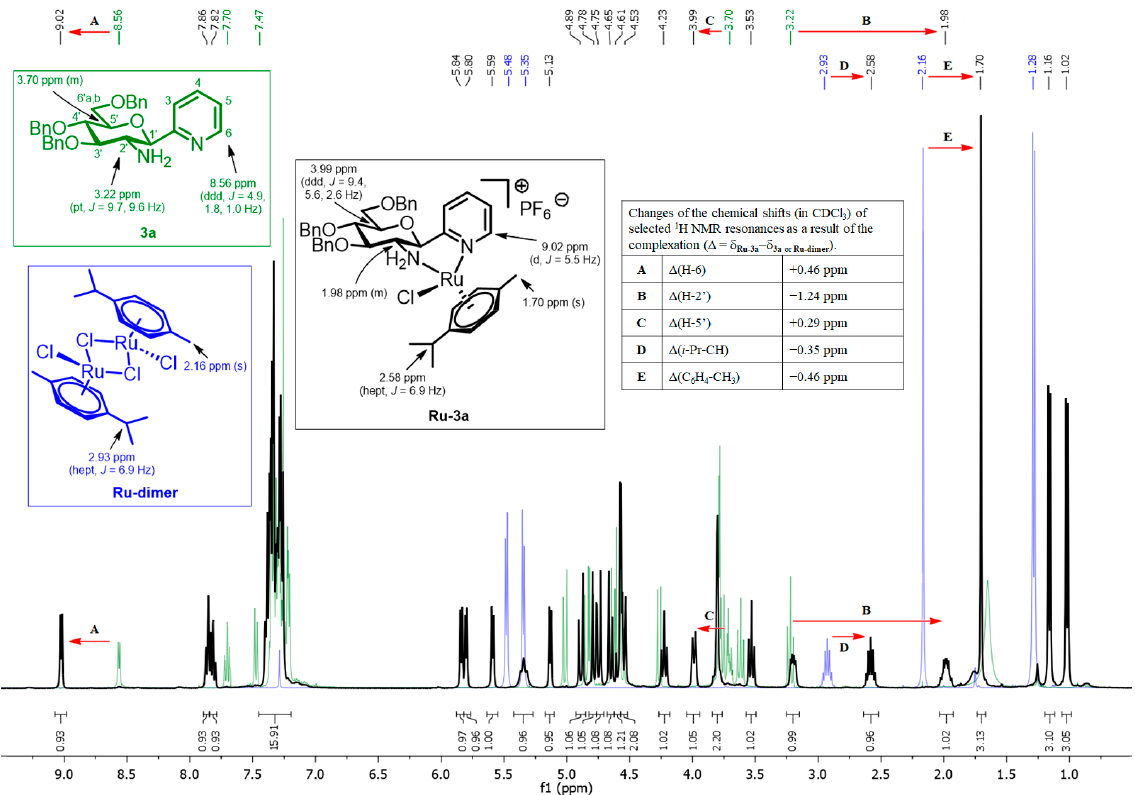
Figure 3. Superposition of the 1 H-NMR spectra of ligand 3a (green) and complexes Ru-dimer (blue) and Ru-3a (black) in CDCl 3 , highlighting the changes in some characteristic resonances as a result of the complexation.